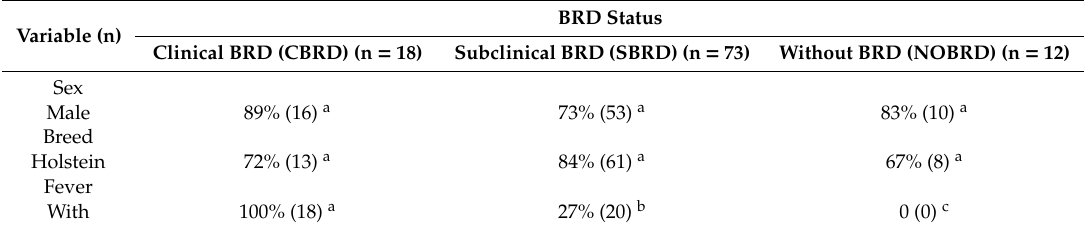
Table 1. Proportion (% (n)) of calves in each category of sex (male or female, only male data shown), breed (Holstein or Jersey, only Holstein data shown), and fever (with or without, only ‘with fever’ shown) for each Bovine Respiratory Disease (BRD) status. Calves were enrolled in the study at 21 ± 6 (mean ± SD) d of age and underwent twice weekly health exams. Fever was defined as rectal temperature ≥ 39 ◦